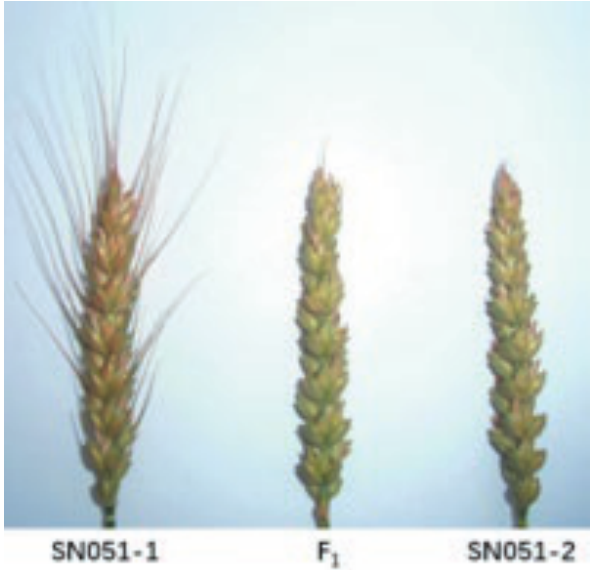
Figure 1. Awn performance of SN051-1, F 1 , and SN051-2. SN051-1: long awn phenotype; SN051-2: short awn phenotype; F 1 : short awn phenotype.